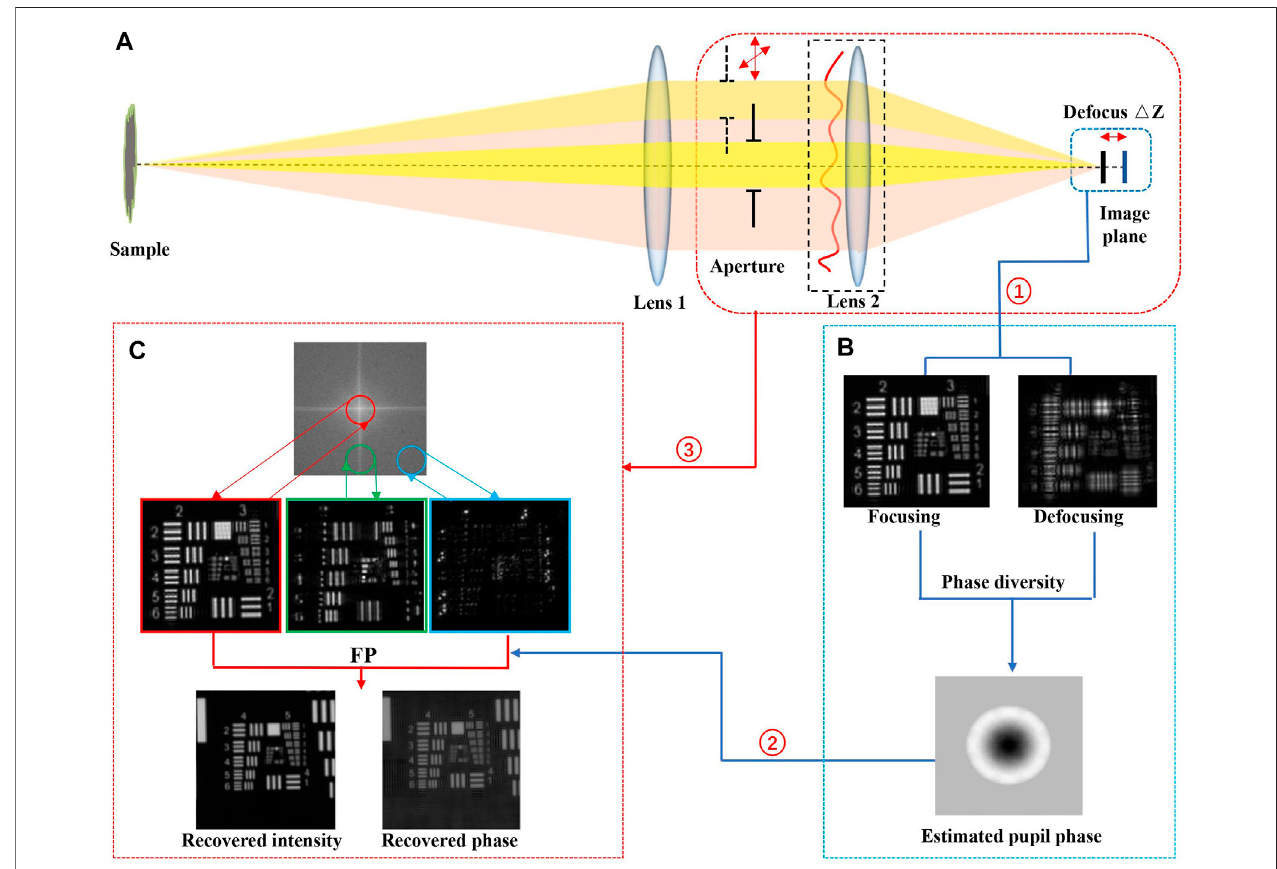
FIGURE 2 | Phase diversity-based Fourier ptychography algorithm fl ow. (A) Phase diversity-based Fourier ptychography method. (B) The phase diversity algorithm. (C) Fourier ptychography algorithm with the corrected pupil functions.